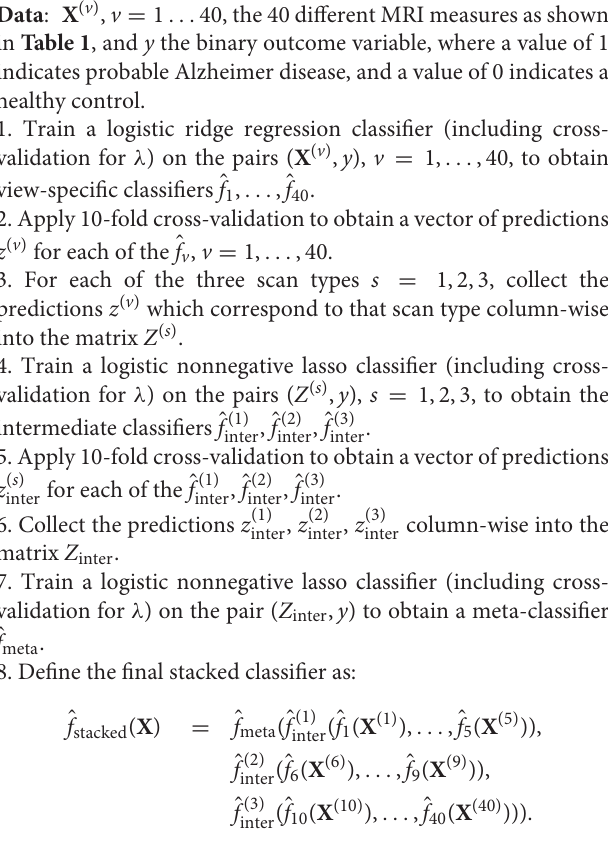
Algorithm 1 StaPLR with 3 levels, as applied to the current data